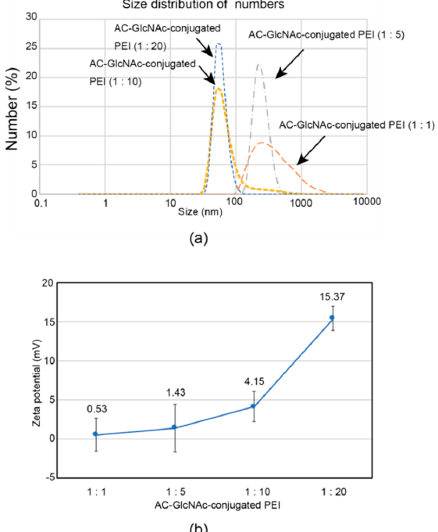
Figure 4. Sizes and zeta potentials of AC-GlcNAc-conjugated polyethyleneimine (PEI) (1:1, 1:5, 1:10, and 1:20) and NF- κ B decoy oligonucleotide complexes ( w/w ratios of 30, 12, 10, and 10, respectively) determined by dynamic light scattering. ( a ) Size distribution of the complexes. ( b ) Zeta potentials of the complexes.